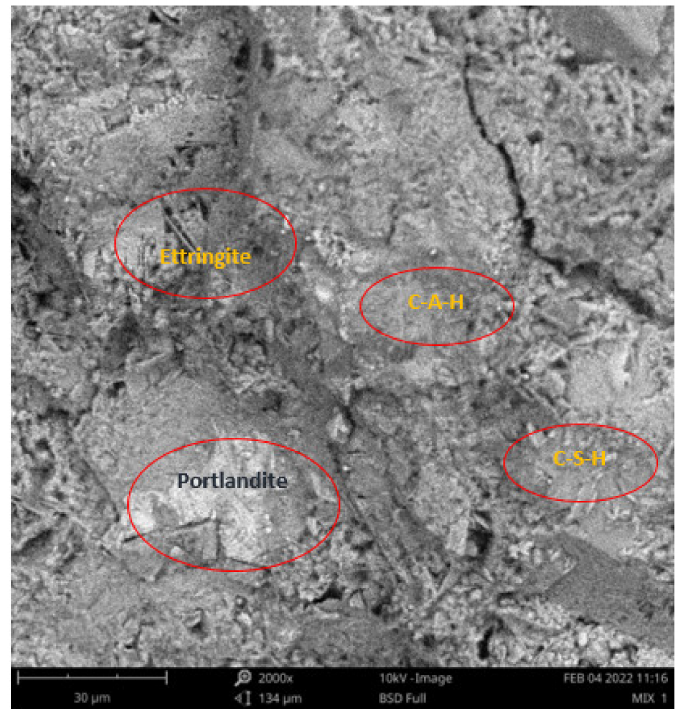
Figure 12. Micrograph of Y 1 concrete